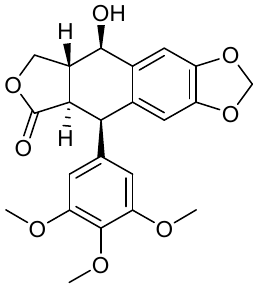
Figure 6. Podophyllotoxin. Figure 6.